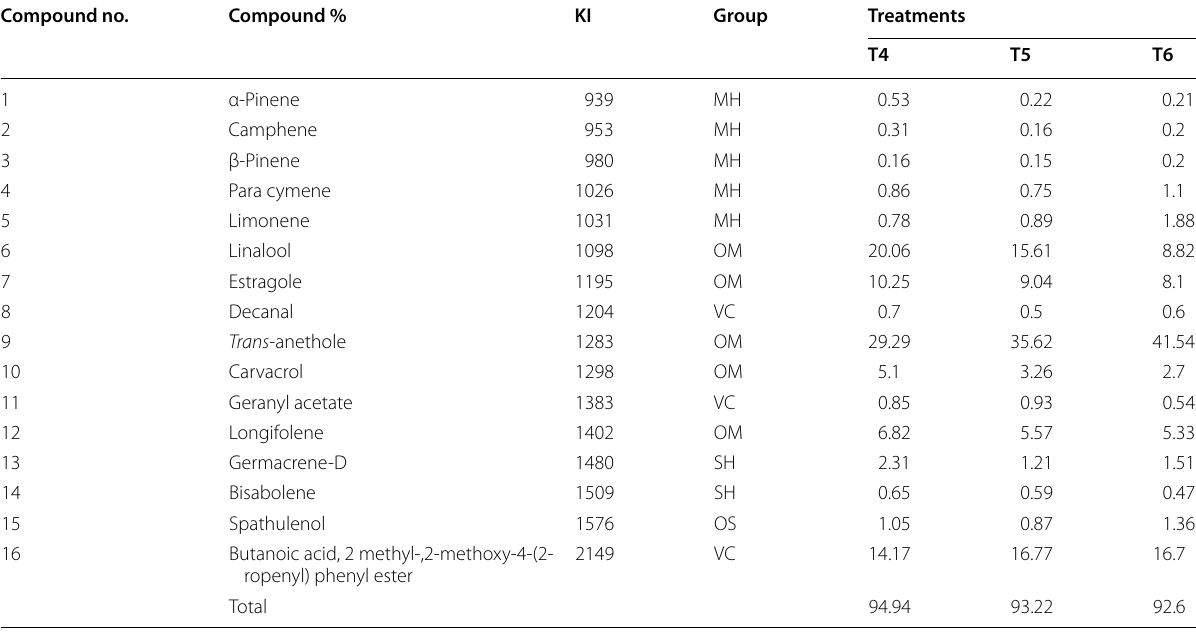
Table 4 Percentage variation of the essential oil constituents of coriander waste under different storage conditions for 1